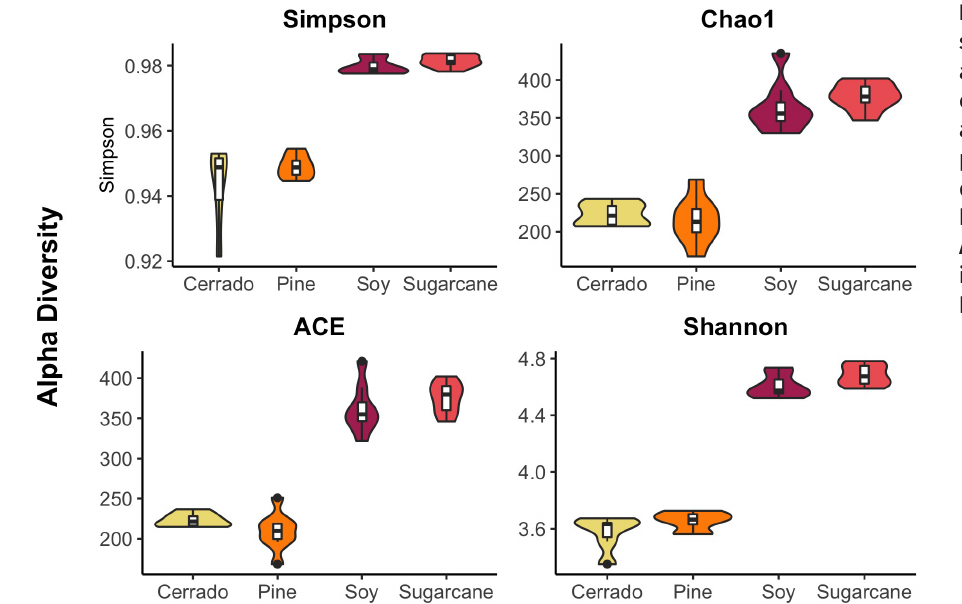
Figure 6 Comparative soil diversity indexes among land use ecosystems. The analysis of violin plot shows alpha- diversity